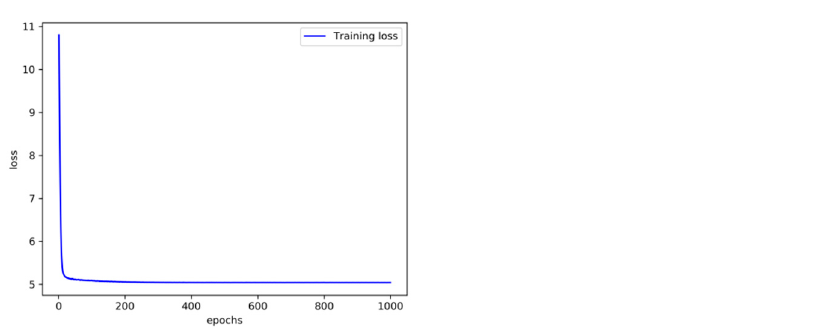
Figure 5. Influence of different latent_dim on detection effect. ( a – h ) correspond to AUC obtained when latent_dim is taken as 2, 4, 6, 8, 10, 12, 14 and 16 respectively.